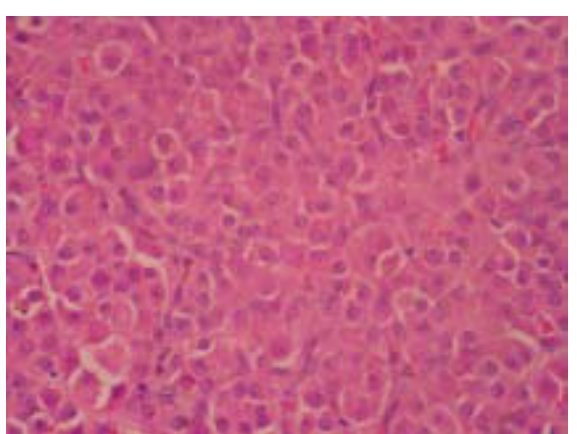
Figure 3. Sections of the right ovarian tumour shows sheets and clusters of cells with abundant eosinophillic cytoplasm, which is compatible with a Sertoli-Leydig cell